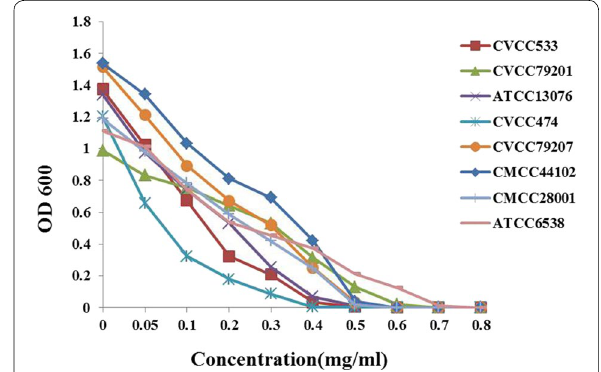
Fig. 5 Broad-spectrum antimicrobial activities was investigated. X axis represented the concentration of a,β-3-trehalosamine and growth curve as measured at OD600 nm of GN59 was plotted on the right Y axis